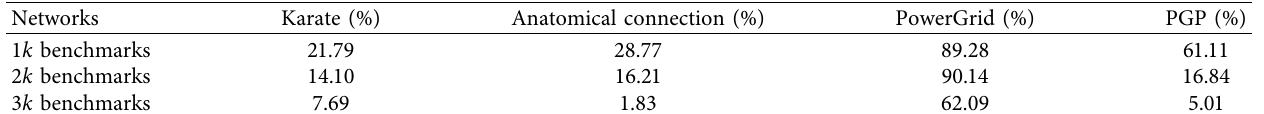
Table 5: The average ratio of the number of actually changed edges in the generated 1 k –3 k benchmarks on four real-life networks with different types and sizes.